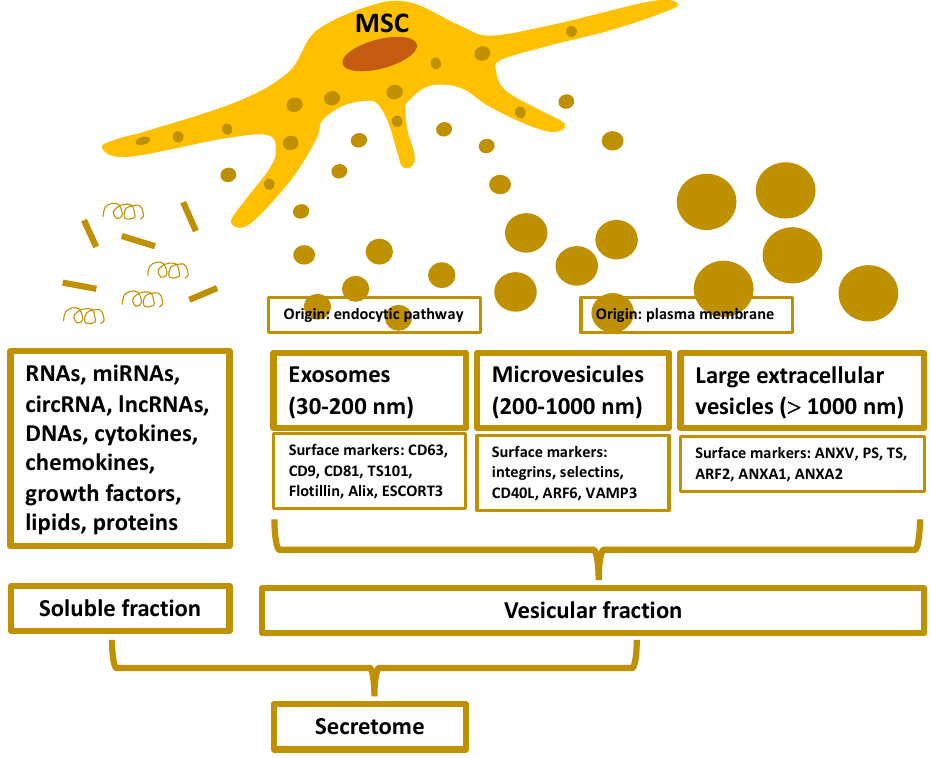
Figure 1. The secretome is defined as the set of substances released from the cell (e.g., mesenchymal stem cells—MSCs) to their surroundings with a wide spectrum of biological action. The figure